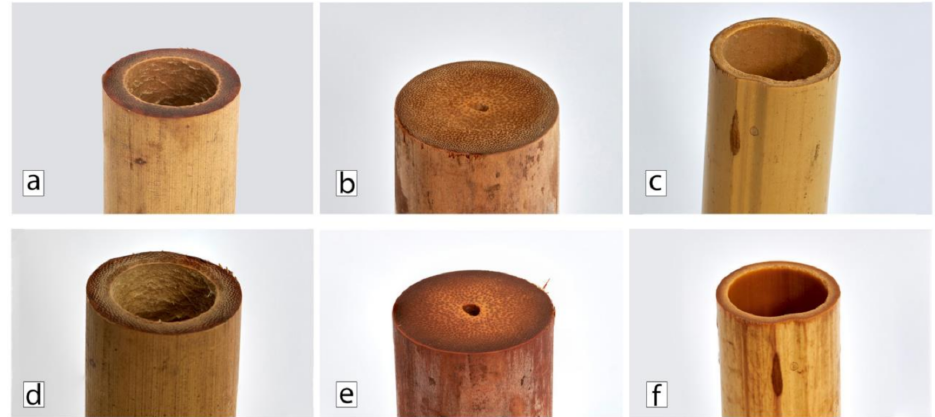
Figure 10. Pictures of AA, DS and PA bamboo culms before (( a ), ( b ), ( c ), respectively) and after (( d ), ( e ), ( f ), respectively) water immersion.